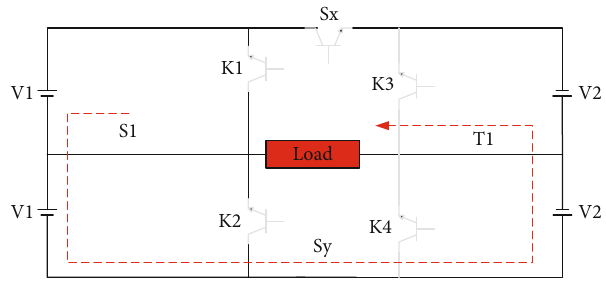
Figure 12: Current fl ow for the 10 th switching pattern.